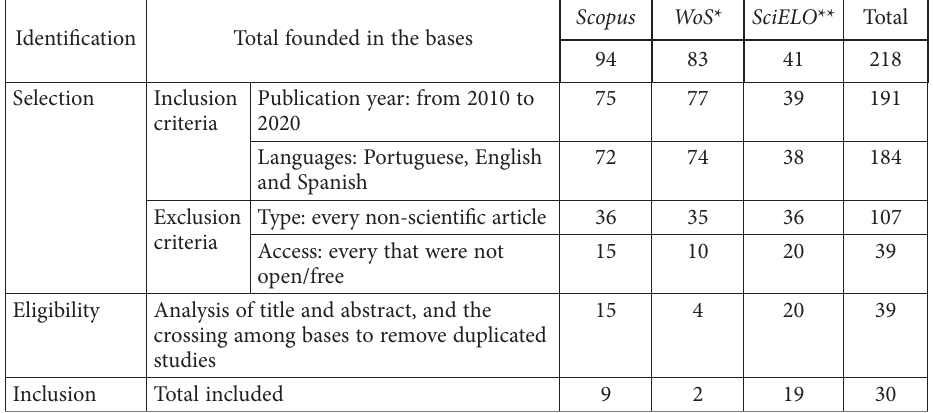
Table 3. Systematic literature review (source: created by